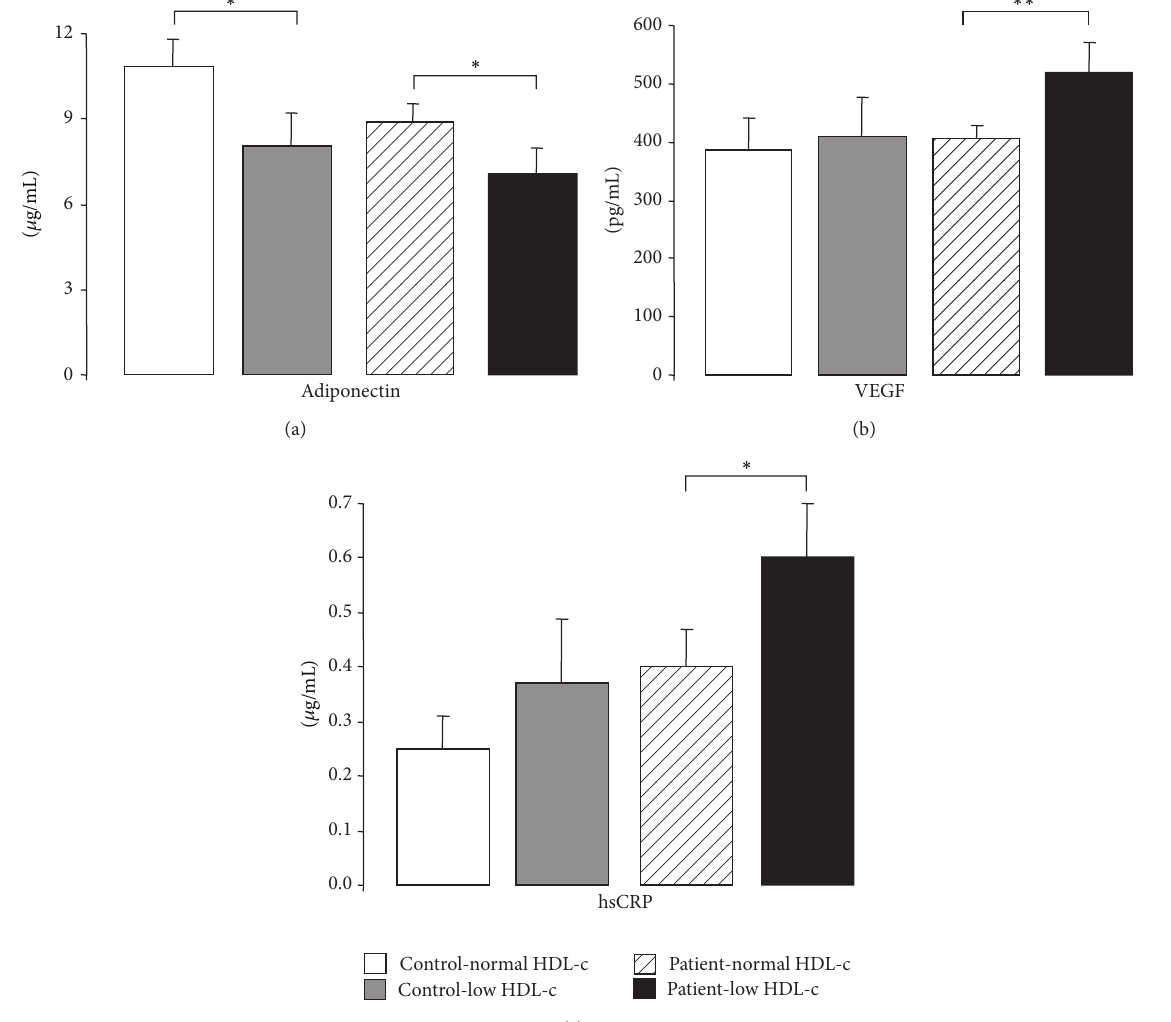
Figure 2: Serum adiponectin (a), VEGF (b), and hsCRP (c) levels, in the study groups. Results are presented as mean ± SEM. ∗ 𝑃 < 0.05 and ∗∗ 𝑃 < 0.01 .